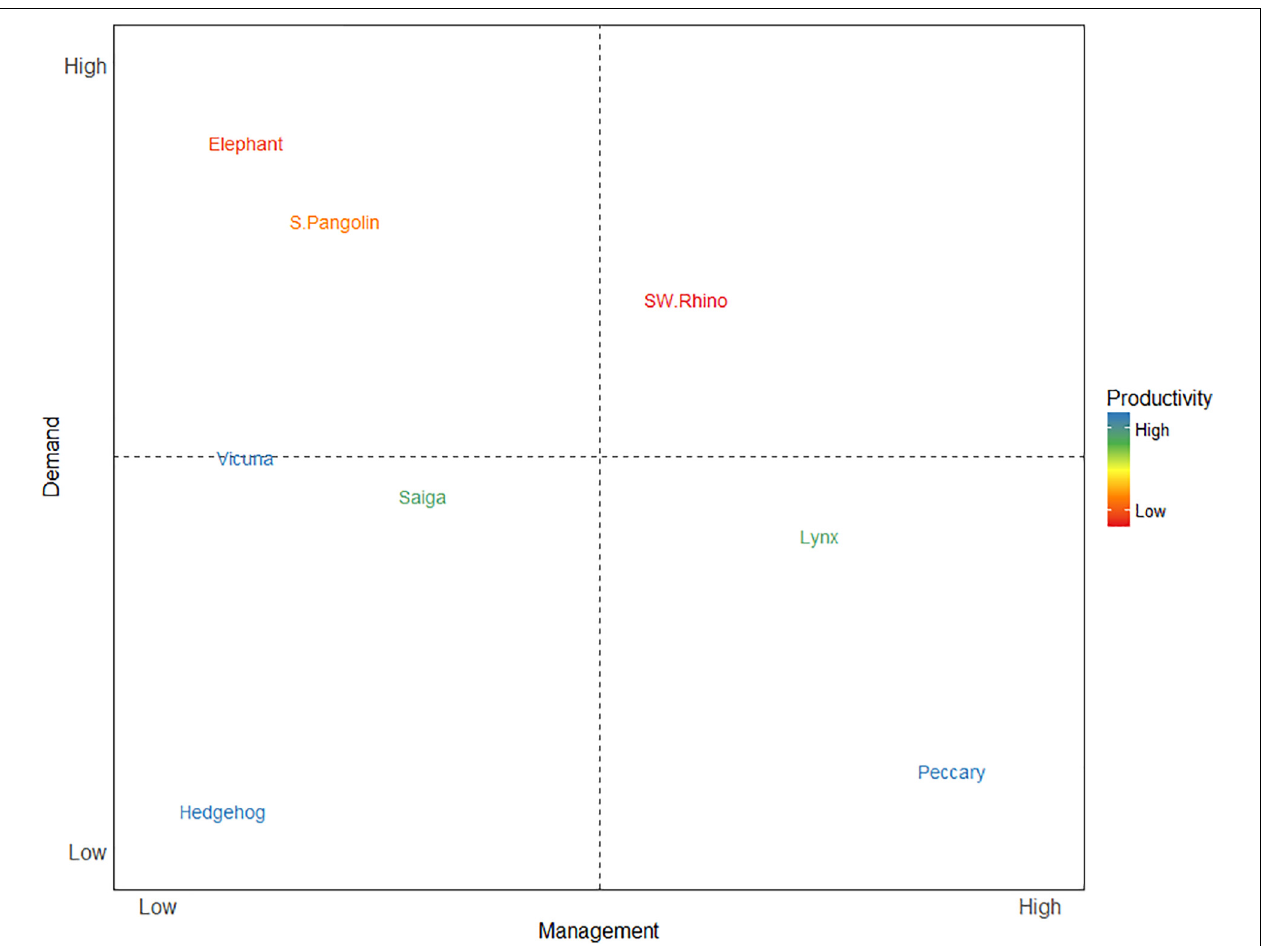
FIGURE 1 | Productivity, demand, and management for different species (S. pangolin = Sunda pangolin; SW rhino = southern white rhino). Species are likely to have a more sustainable future if the demand is low and the management effectiveness is high, but the relative importance of these, hence which policies should be adopted, depend on productivity. This figure does not help in determining whether a trade ban or managed legal trade will be more effective at improving species sustainability. It does highlight which species are most likely to need help—those in the top left corner with low productivity. Please note, these results are illustrative and